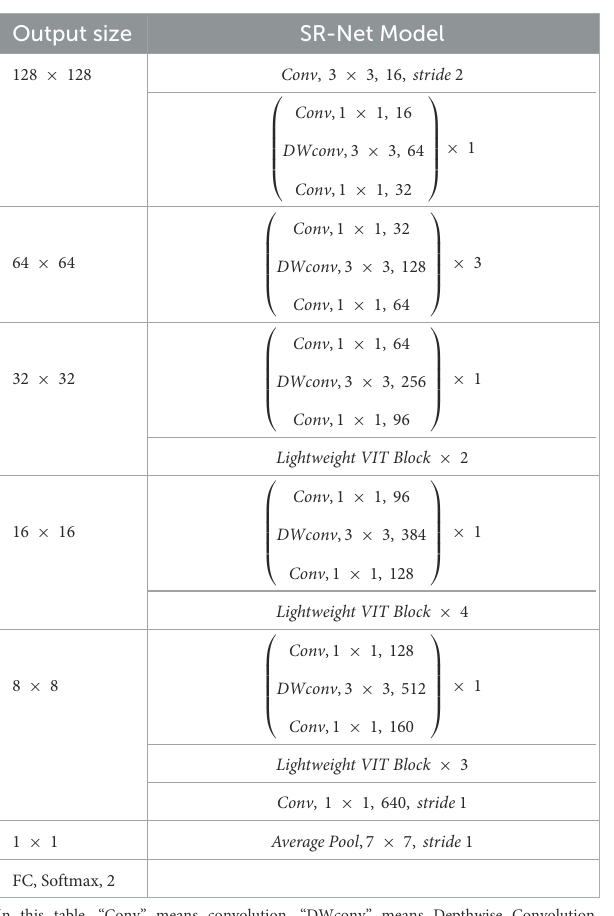
Algorithm 2. Vision